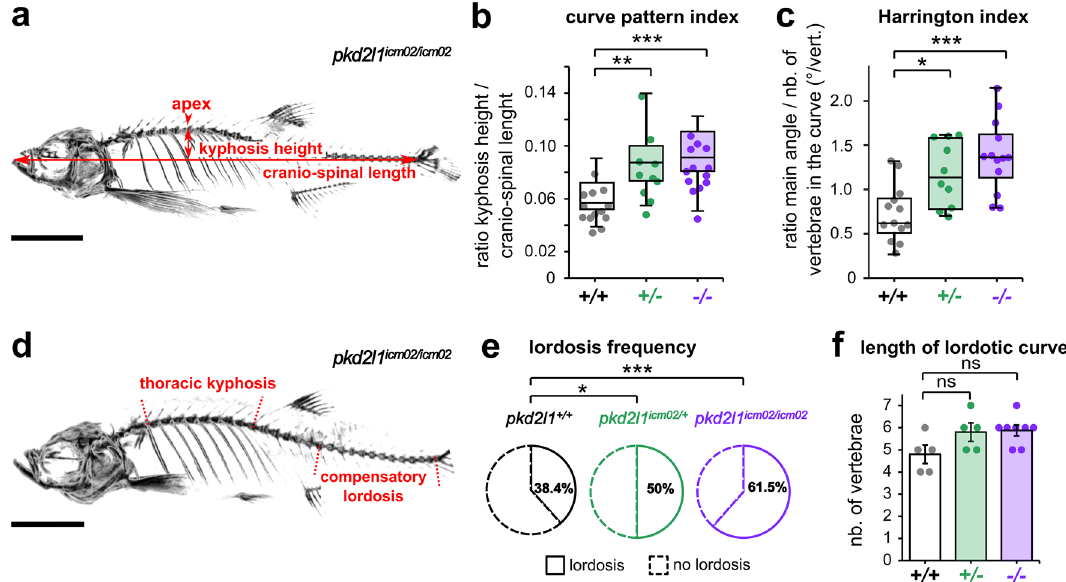
Figure 4. Adult pkd2l1 mutants develop a sagittal imbalance of the spine. ( a ) Representative 3D micro- computed tomography reconstruction of a pkd2l1 icm02/icm02 mutant (18 months-old) used to exemplify the evaluation in the sagittal plane of the kyphosis height, the cranio-spinal length and the kyphosis apex. Scale bar 0.5 cm. ( b, c ) Distribution of the curve pattern index ( b ) and Harrington index ( c ) in wild-type (black, + / + , n = 13), heterozygous (green, + /−, n = 10) and pkd2l1 icm02/icm02 mutants (purple, −/−, n = 13). Boxplots represent median values ± IQR. Each point represents a single animal. *: p < 0.05, **: p < 0.01, ***: p < 0.001, Mann– Whitney test. ( d ) Representative 3D micro-computed tomography reconstruction used to identify in the sagittal plane the thoracic kyphosis and a compensatory lordosis in the caudal region of the spine, exemplified in a 18 months-old pkd2l1 icm02/icm02 mutant. Scale bar: 0.5 cm. ( e ) Pie charts representing the frequency of caudal lordotic curves in wild-type (black, n = 13), heterozygous (green, n = 10) and pkd2l1 icm02/icm02 mutants (purple, n = 13). *: p < 0.05, ***: p < 0.001, Chi-Square test. ( f ) Histogram representing the length of the compensatory curve in lordotic wild-type (grey, + / + , n = 5), heterozygous (green, + /−, n = 5) and pkd2l1 icm02/icm02 animals (purple, −/−, n = 6). Each point represents a single animal. Histograms represent mean values ± SEM. ns: p > 0.05, Mann–Whitney test.